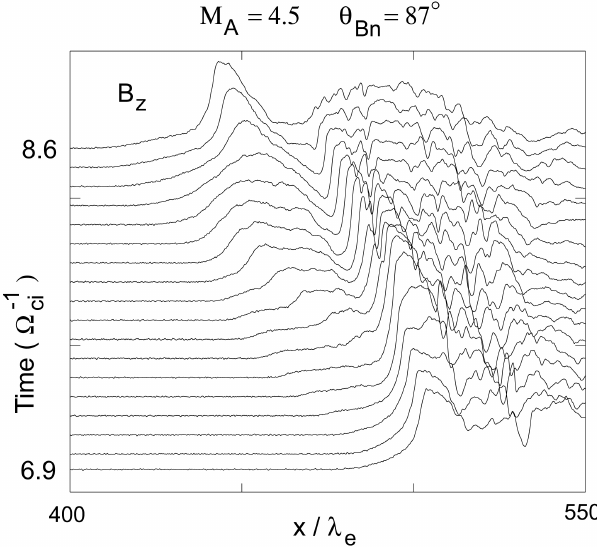
Fig. 3. Magnetic field B z component stacked in time for the ion to electron mass ratio 400 run. Time runs from bottom to top.